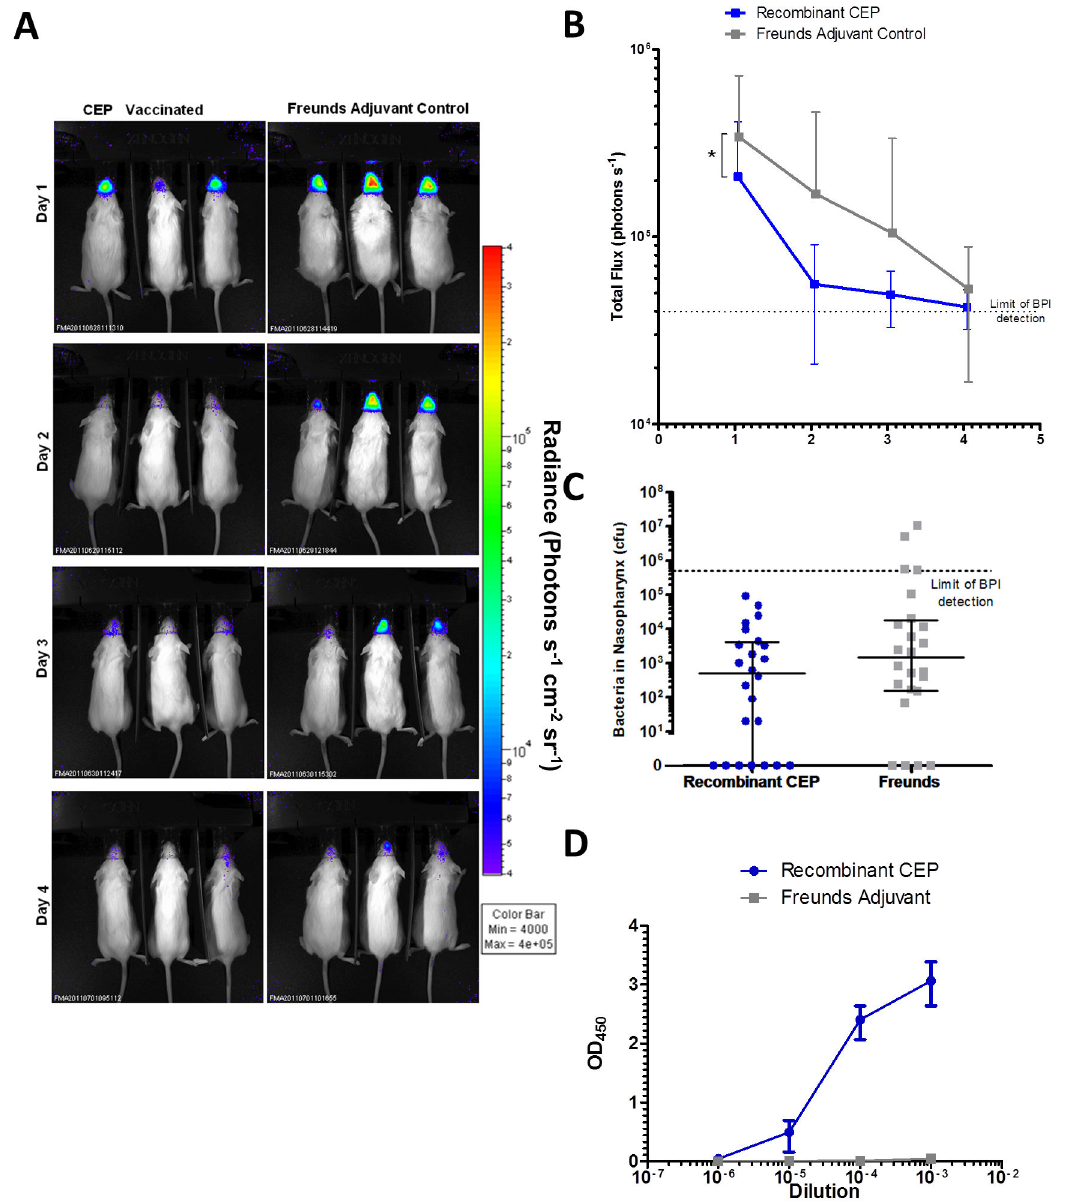
Figure 8. BPI to determine protective efficacy of a vaccine based on SpyCEP. Mice were immunized with either Freund’s adjuvant, or SpyCEP + Freund’s adjuvant, and then challenged with H347::lux. The mice were imaged for 4 days post infection using an IVIS 100 system (A). Total flux from mice in each group was compared over the time course (B, Repeated measures Two way ANOVA with Bonferroni correction, * p <0.05) Colony counts were obtained from dissections performed on the final day of infection (C). Serum antibody responses against SpyCEP from tail bleeds taken before infections were measured by ELISA (D) Error bars indicate mean and